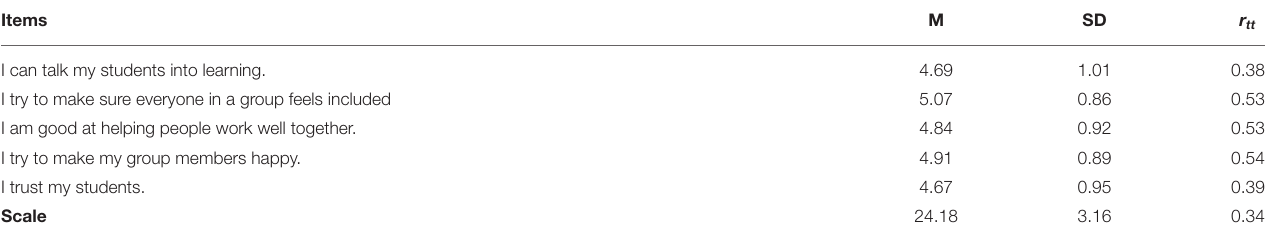
TABLE A4 | Supportive teaching scale–means, standard deviations, and item-total score-corrected correlations of the items ( N = 1,944, α = 0.72, ω h = 0.71, λ 6 = 0.69, ρ = 0.73). Items M SD r